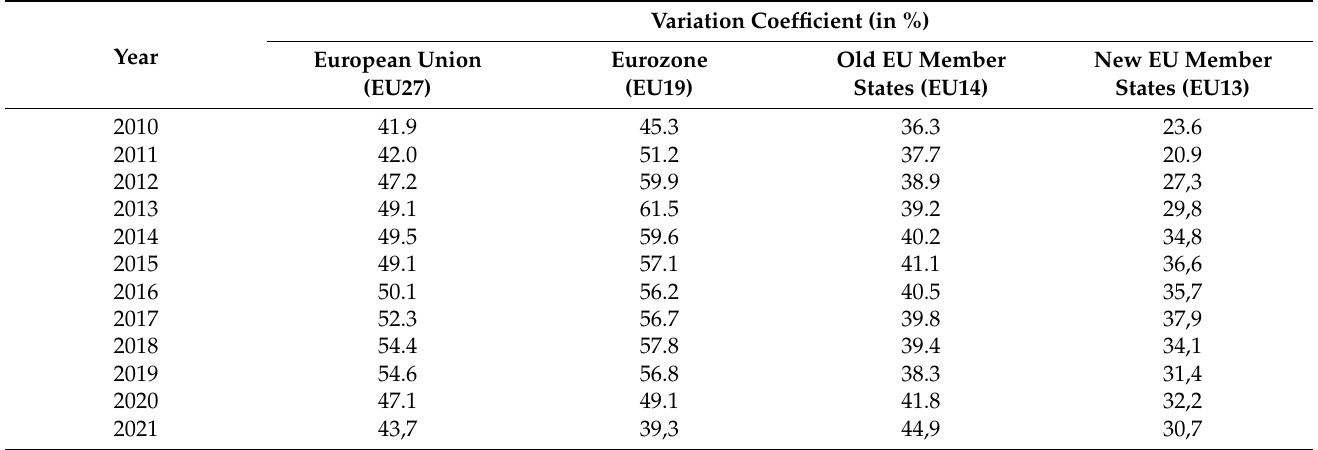
Table 4. Variation coefficient of unemployment rate (2010–2021). Variation Coefficient (in